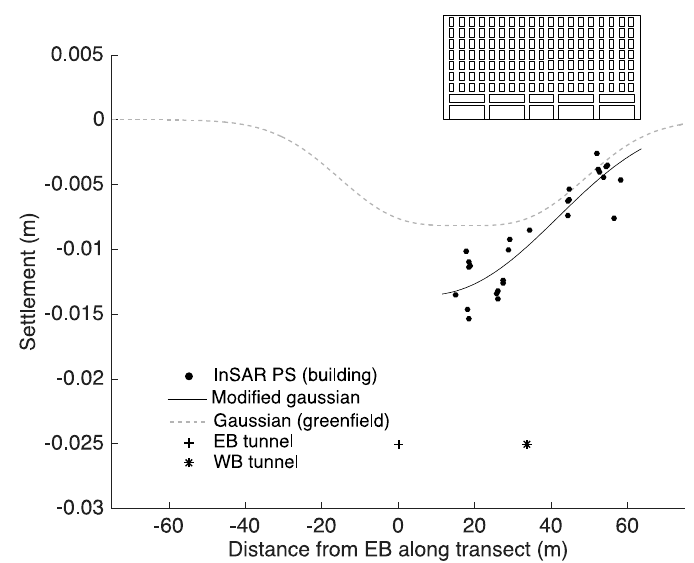
Figure 4. Example of MT-InSAR-based displacements at the top of the building.